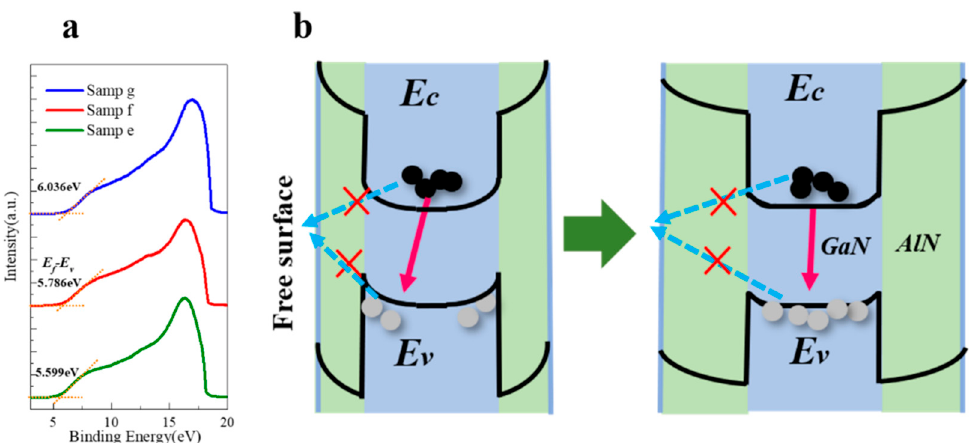
Figure 4. ( a ) Ultraviolet photoelectron spectroscopy ( UPS) spectra of the samples with different AlN shell thicknesses. The spectra have been vertically shifted for clarity. ( b ) Schematics of the band structures and distributions of electrons and holes for samples with different AlN shell thicknesses. Arrows indicate the related transitions.